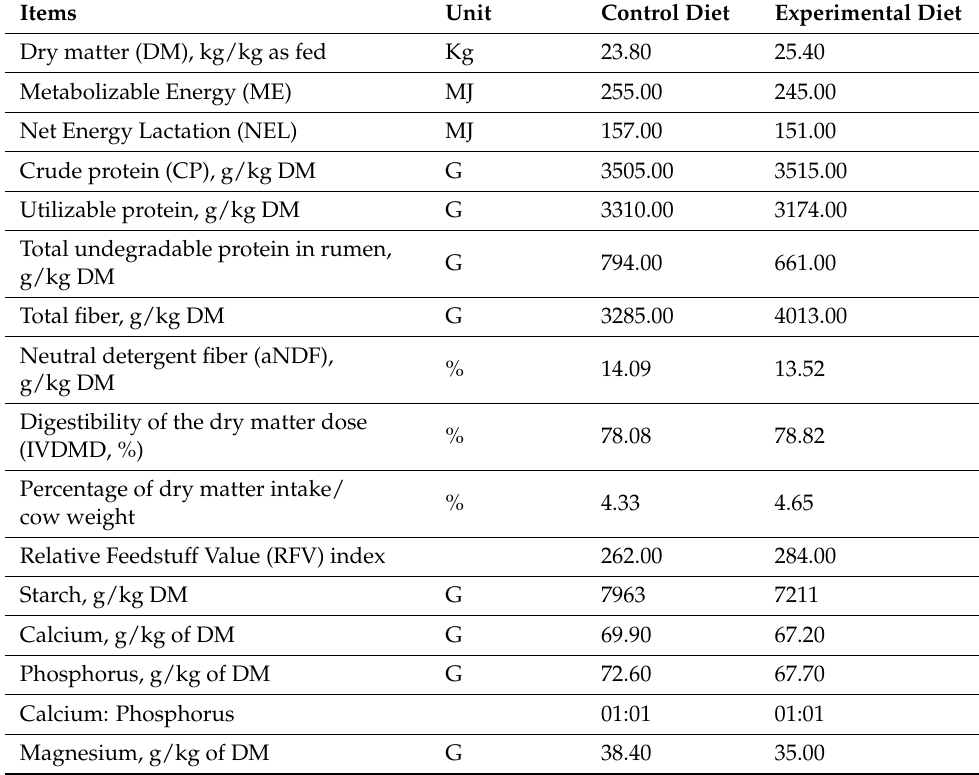
Table 4. The composition of the standard and experimental diets (with the additive of dried apple pomace) was dedicated to cows during the